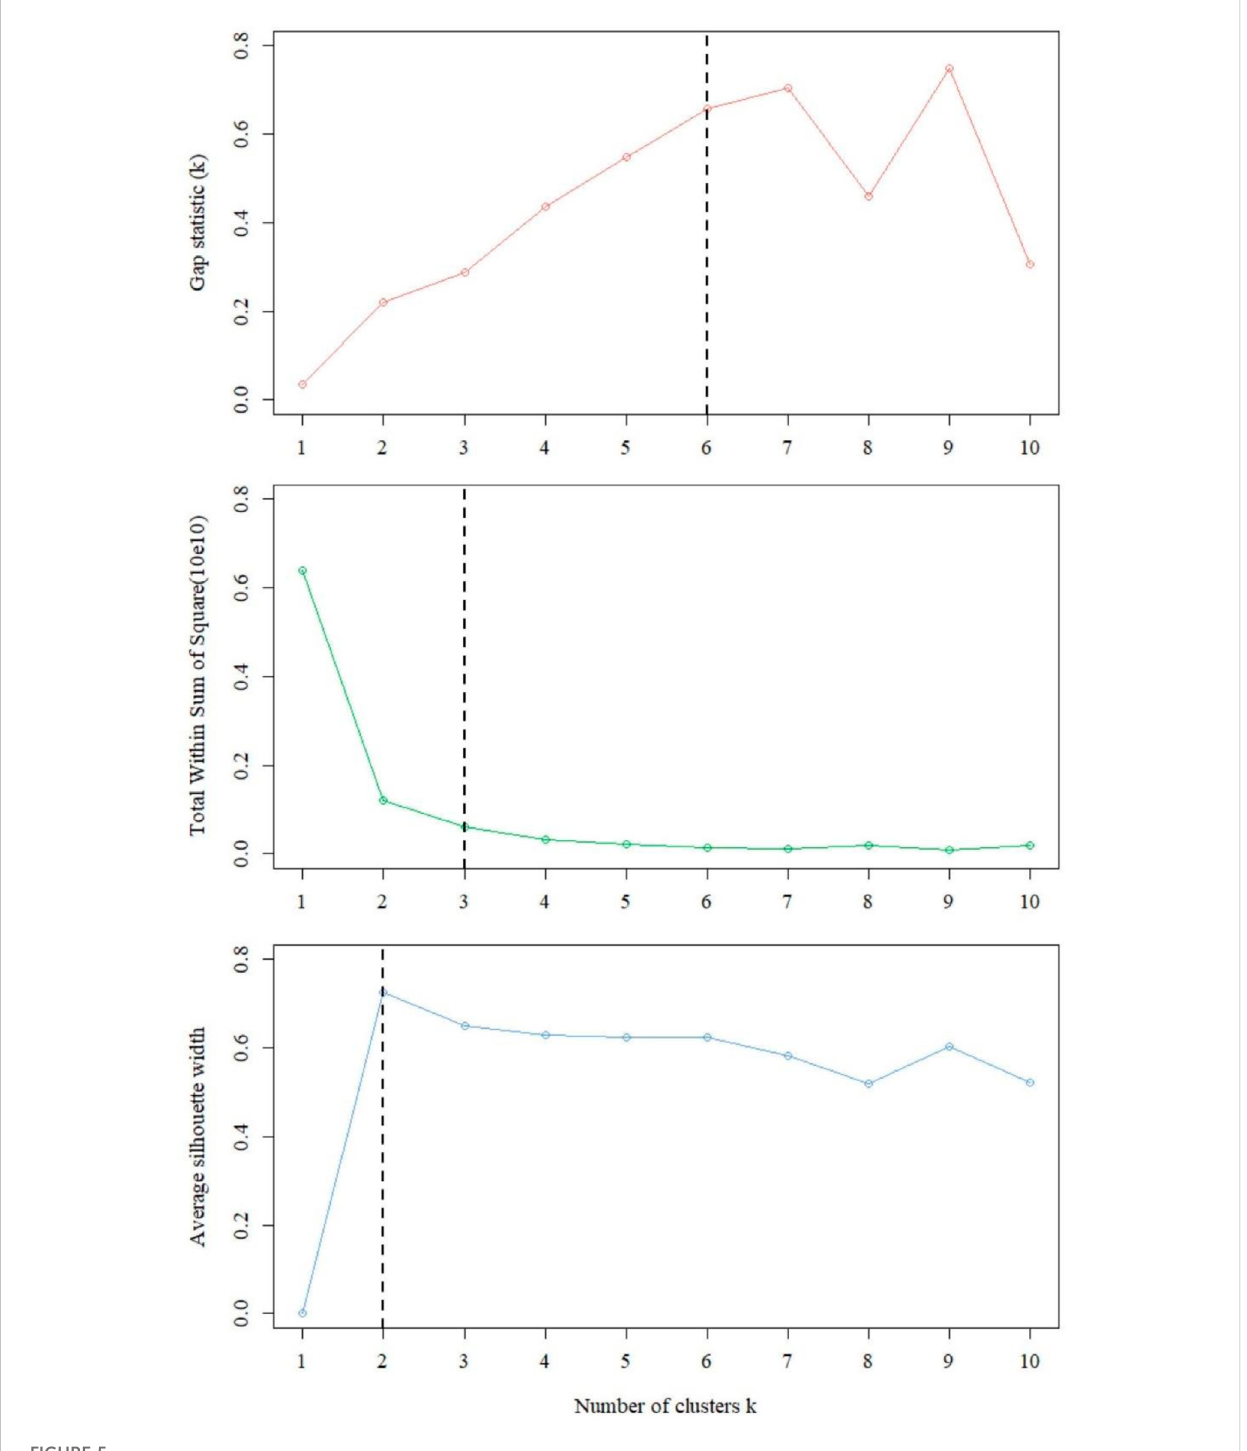
FIGURE 5 Optimal number of clusters in different